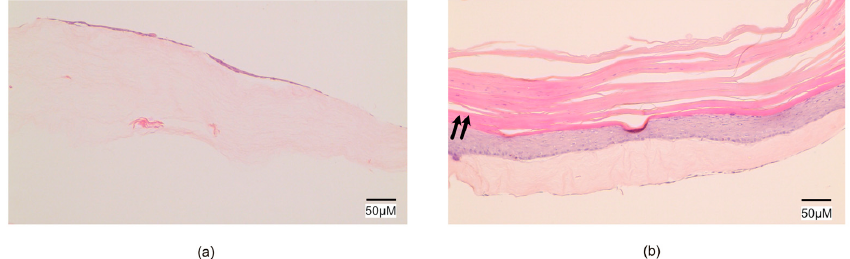
Figure 1. Epithelium covering the scaffold in vitro. Microphotograph of the transplants described in 2.1 with conventional H&E staining. ( a ) After 2 weeks of in vitro culture, a single-layer epithelium